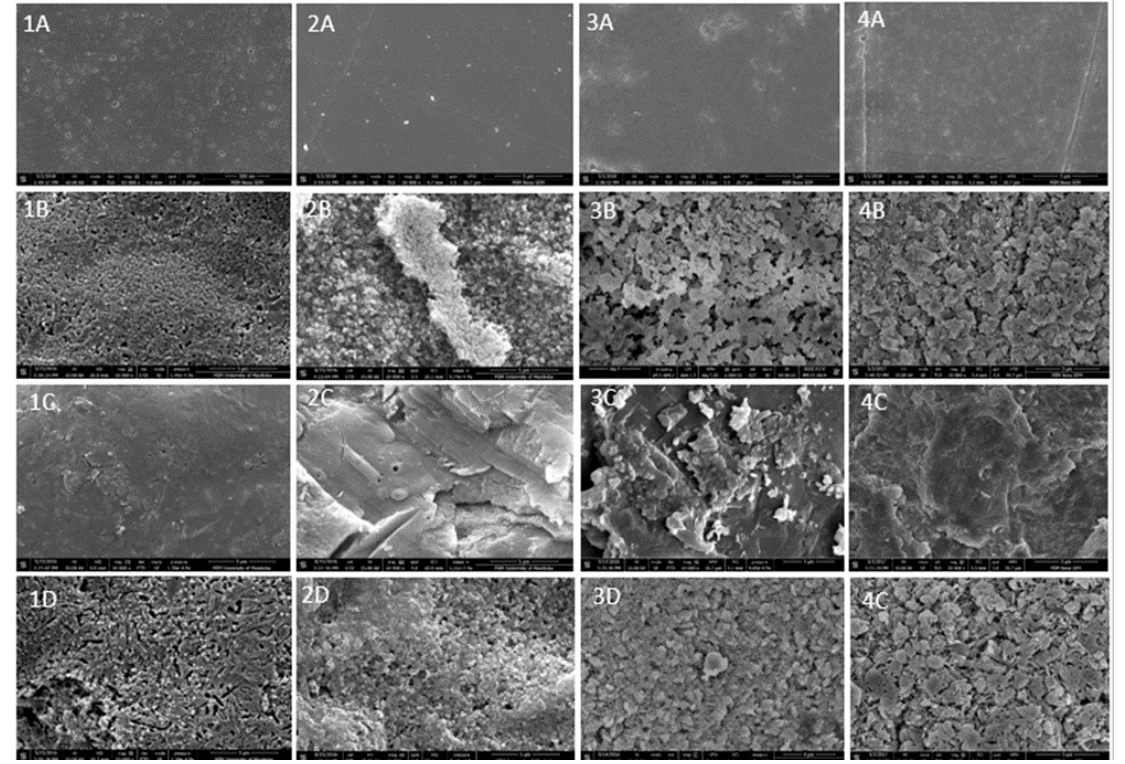
Figure 1. SEM images show the surface microstructure after different surface treatments of four LDGC, IPS e. max ® CAD ( 1 ) Vita Suprinity ® ( 2 ), Celtra Duo ® ( 3 ), n!ce ( 4 ). ( A ) Control, ( B ) HF, ( C ) SB, ( D ) SB + HF. Table 2. Mean (Ra) nm and (standard deviation) of lithium-silicate-based glass-ceramic roughness with different surface treatments.